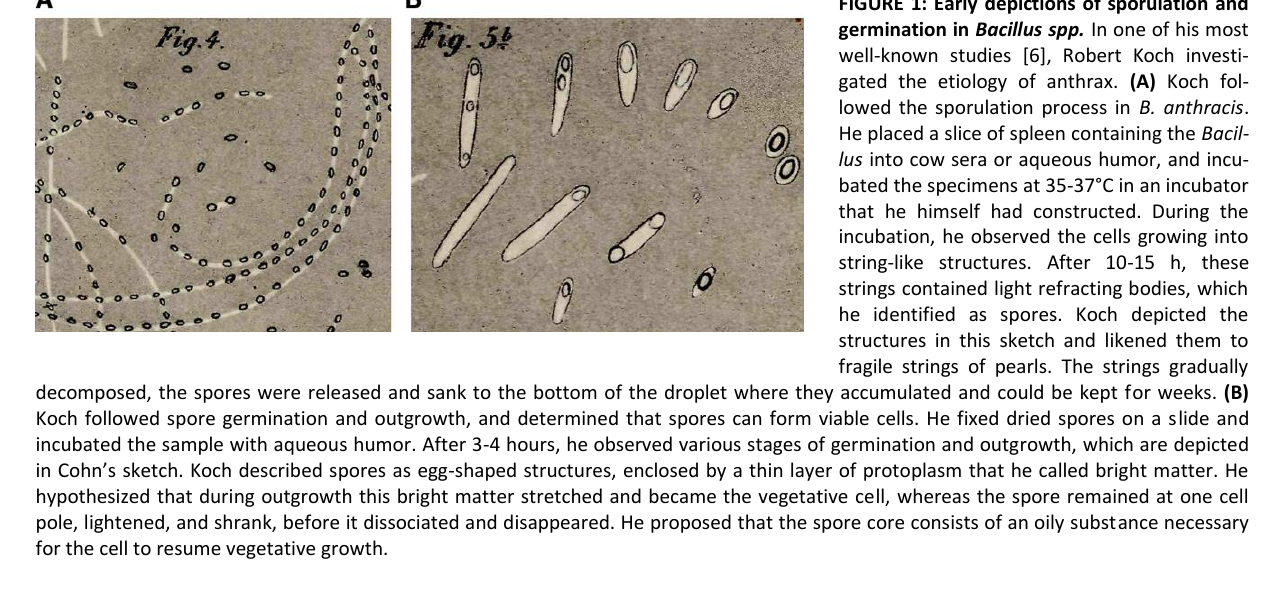
FIGURE 1: Early depictions of sporulation and germination in Bacillus spp. In one of his most well-known studies [6], Robert Koch investi- gated the etiology of anthrax. (A) Koch fol- lowed the sporulation process in B. anthracis